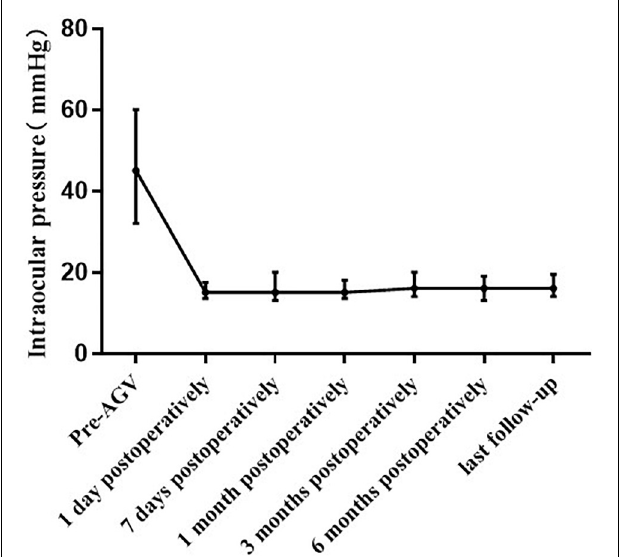
FIGURE 2 | Line chart of the intraocular pressure before and after pars plana Ahmed valve implantation, with postoperative assessments at 1 day, 7 days, 1 month, 3 months, 6 months, and last follow up.